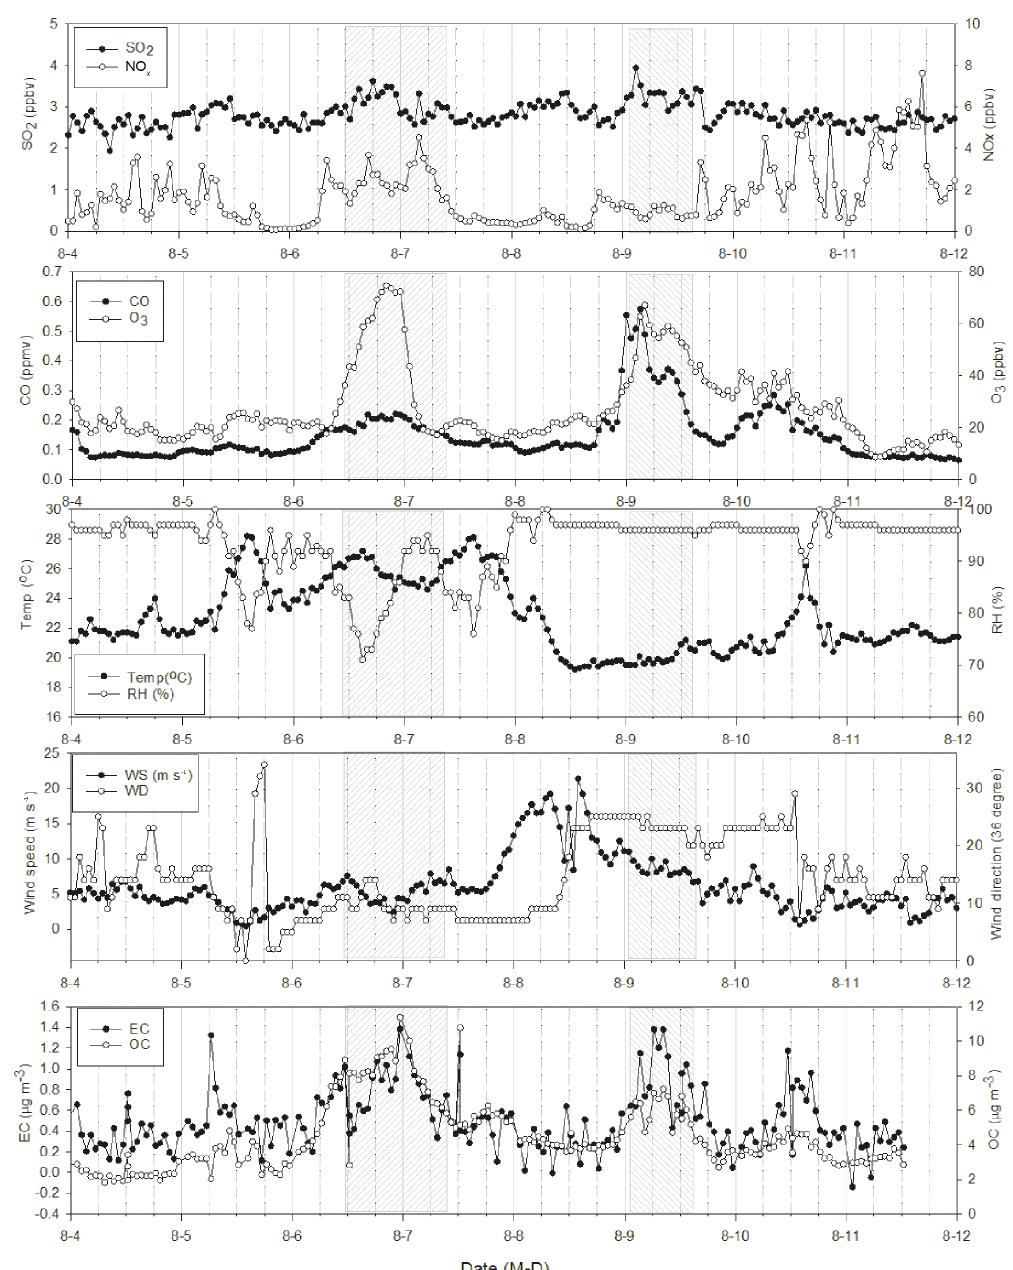
Figure 4. Hourly measurements of SO 2 , NO x , CO, O 3 , EC, OC, and meteorological parameters for the entire sampling